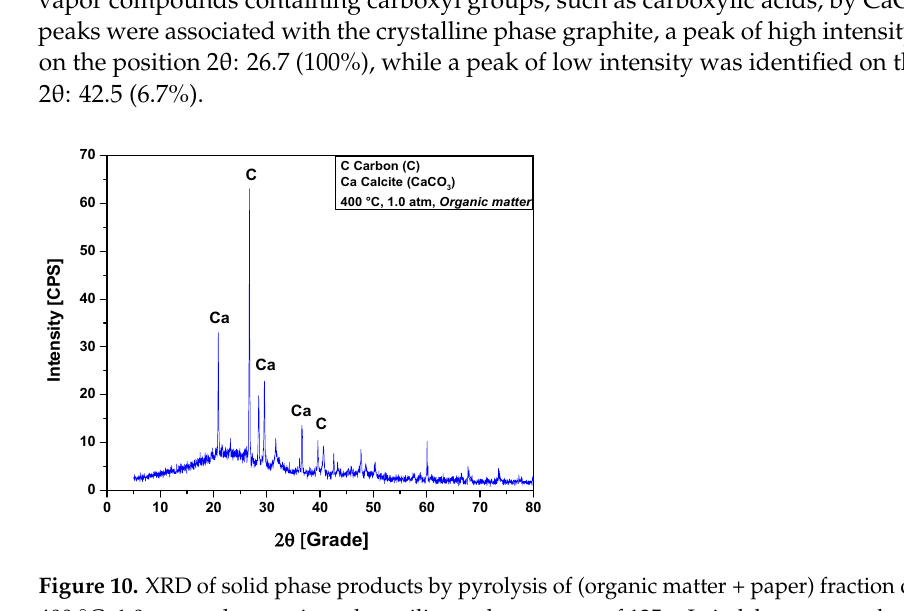
Figure 10. XRD of solid phase products by pyrolysis of (organic matter + paper) fraction of MHSW at 400 °C, 1.0 atmosphere, using a borosilicate glass reactor of 125 mL, in laboratory scale. The XRD analysis of bio-char obtained by pyrolysis of (organic matter + paper) frac- tion of MHSW at 450 °C, 1.0 atmosphere, shown in Figure 11, identified the presence of two crystalline phase, CaCO 3 (Calcite) and graphite (C). The XRD shows the presence of three peaks associated with the crystalline phase CaCO 3 (Calcite), one of high intensity on the position 2 θ : 29.5 (100%), another of medium intensity on the position 2 θ : 20.8 (50.7%), and a third of low intensity on the position 2 θ : 36.6 (16%). Three peaks were associated with the crystalline phase graphite (C), one peak of high intensity observed on the position 2 θ : 26.7 (100%), and two peaks of low intensity identified on the positions 2 θ : 42.5 (6.7%) and 2 θ : 60.0 (15%).